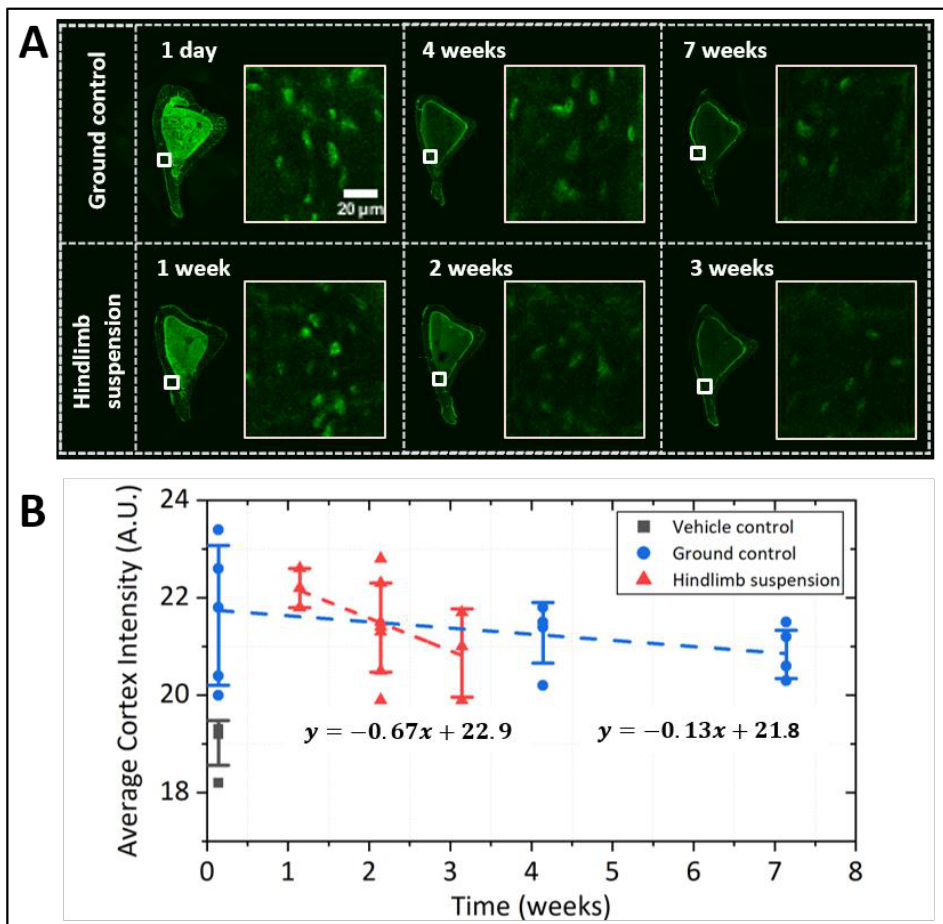
Figure 5. Pulse-chase experiment on metabolically labeled osteocytic PCM in hindlimb suspended mice. ( A ) Representative images of tibial cross sections (left) and magnified regions of the anterior-medial portion of the cortex (white boxes, right) from ground control or hindlimb suspended mice at various time points. ( B ) PCM labeling intensity (averaged across entire sections) showed a linear decrease over time, and the slope was ~5 times steeper in the hindlimb suspended group than the ground control ( p = 0.13). The decay of PCM labeling intensities, after subtraction of background (the mean value from the vehicle control group), yielded the half-lives of osteocytic PCM at 75 d and 20 d for ground control and hindlimb suspension groups, respectively. Data were measured on sections from both tibiae per mouse, one mouse at the one-day or one-week time point and two mice per time point afterward.